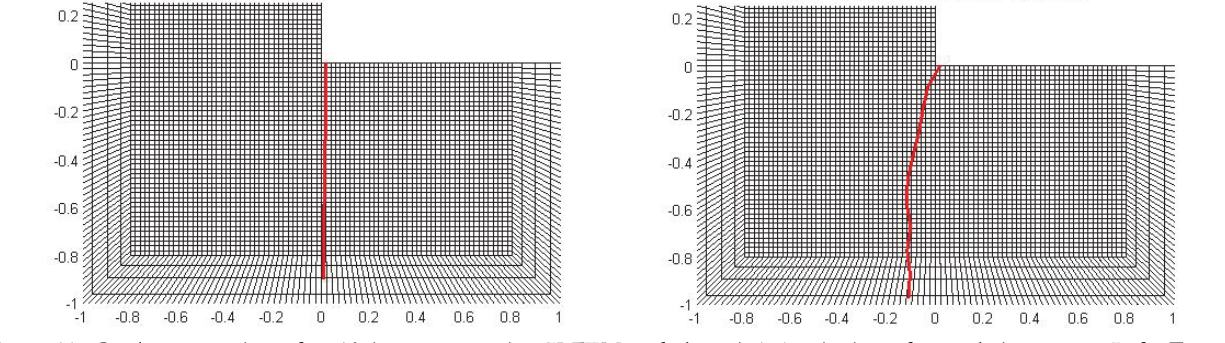
Figure 11: Crack propagation after 10 increments using X-FEM and the min(  ) criterion after each increment. Left, E indenter = 10 3 MPa; right, E indenter =10 8 MPa. E specimen = 72·10 3 MPa. C